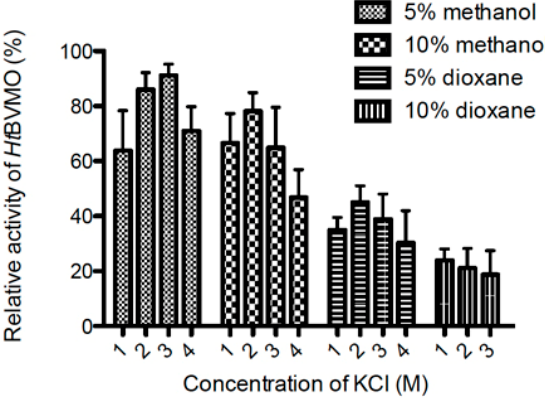
Figure 7. Organic solvents’ effect on the activity of Ht BVMO at different concentrations of KCl (M). Enzyme activity was assayed under standard conditions; results were expressed as relative activities (%) with respect to that observed in the absence of solvent at 3 M KCl.